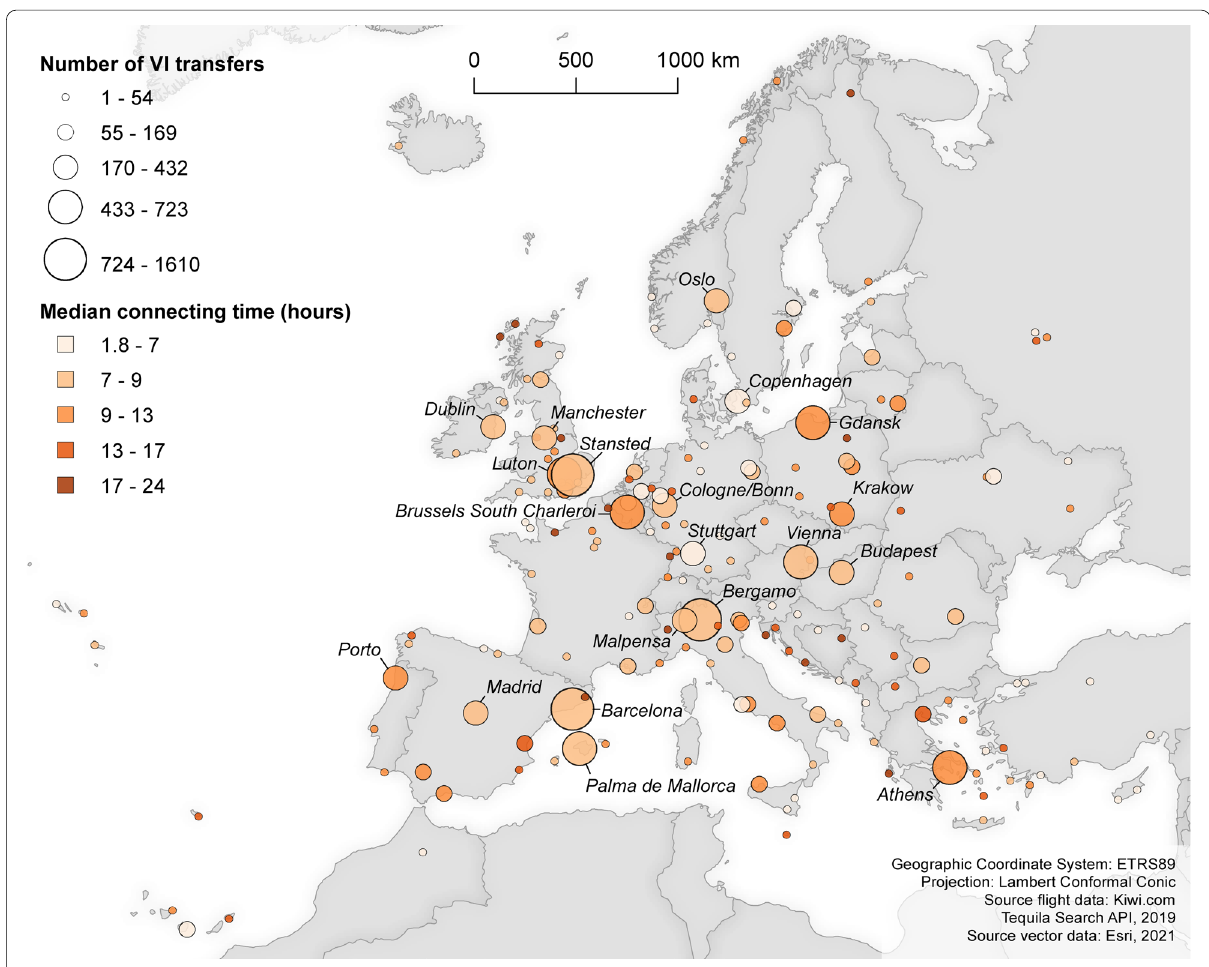
Fig. 4 Connecting within the virtually interlined flight network (02 October 2019, data collection round